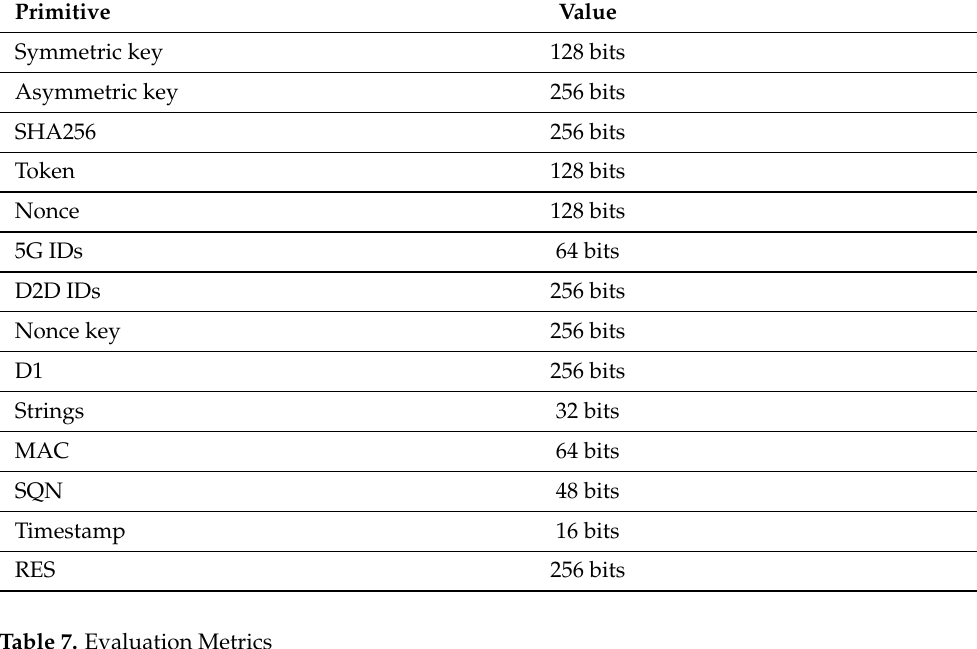
Table 7. Evaluation Metrics